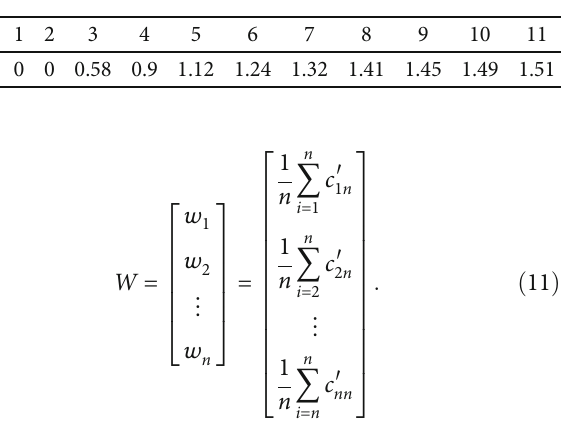
Table 2: Random consistency